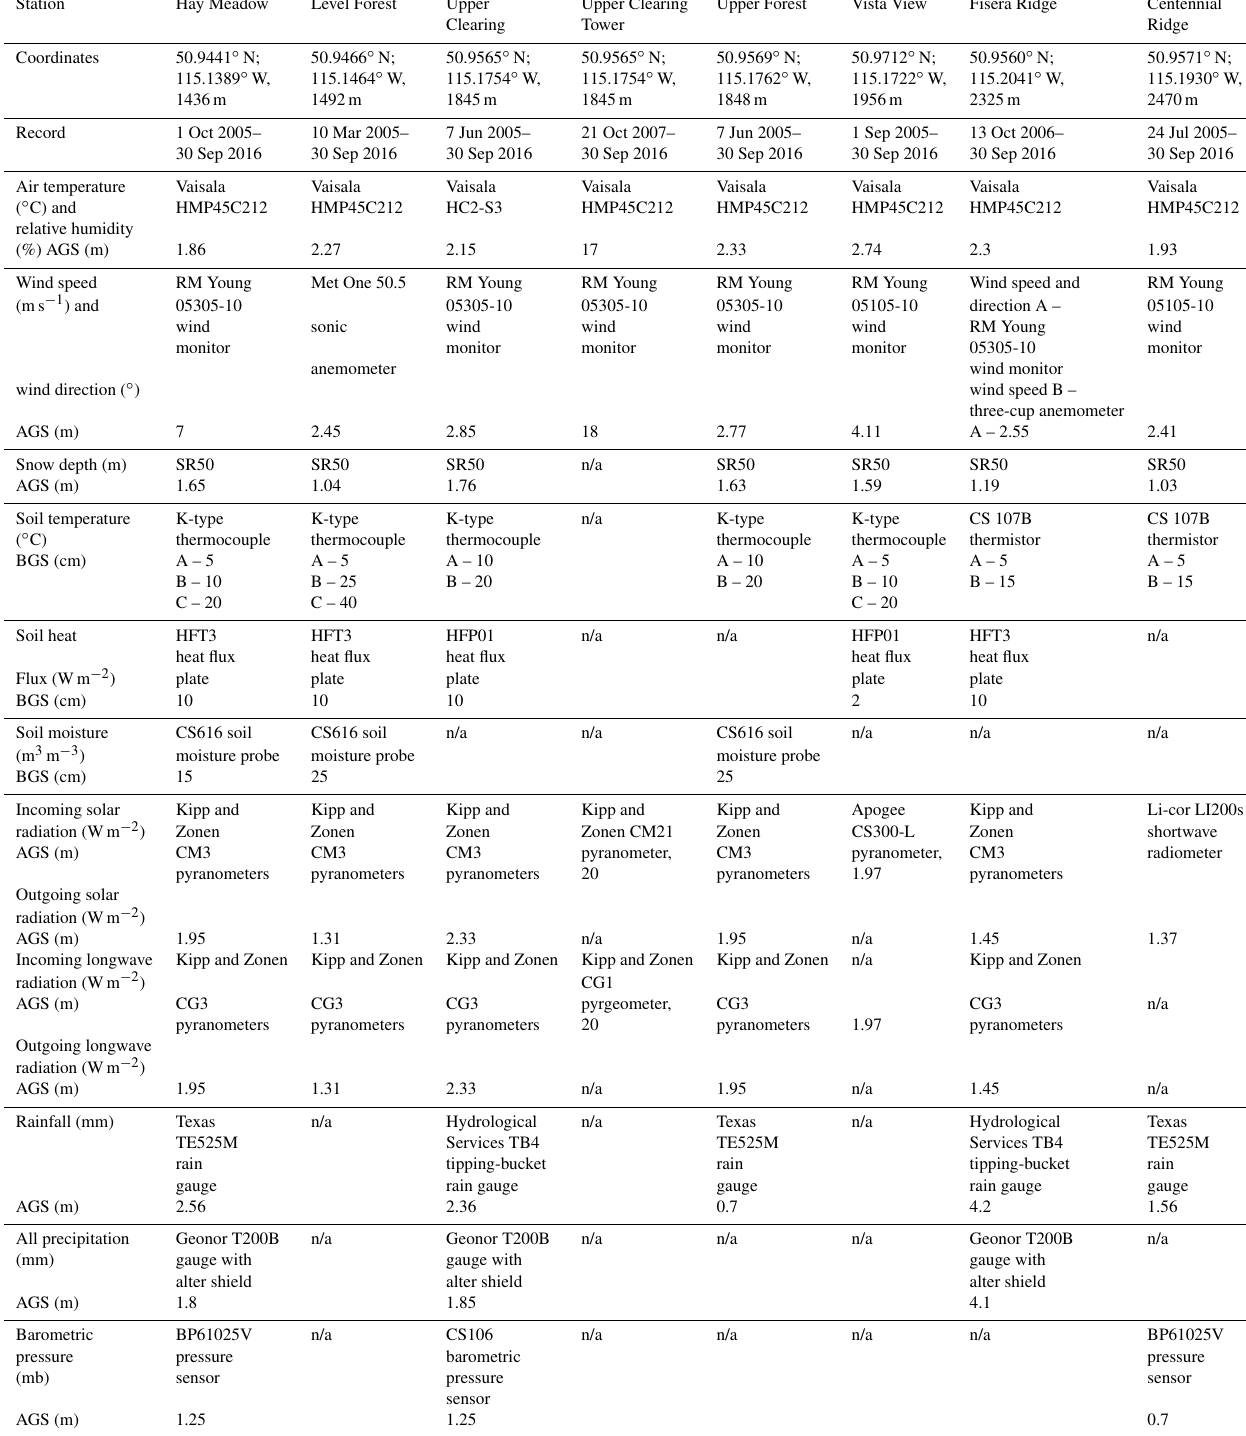
Table 2. Hydrometeorological variables, instrumentation, and height from the recent stations at the Marmot Creek Research Basin. AGS and BGS denote the distance above ground surface and below ground surface, respectively; n/a denotes not